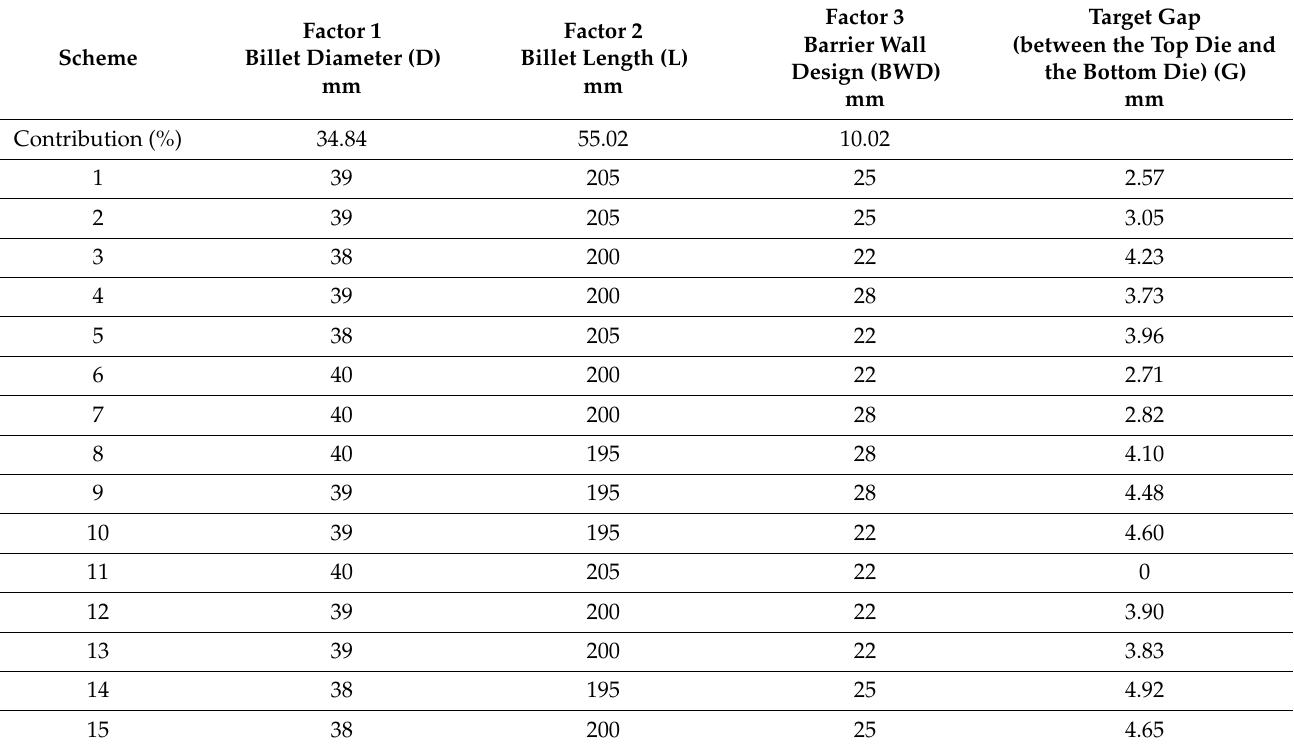
Table 5. Experimental and simulation results of various parameter